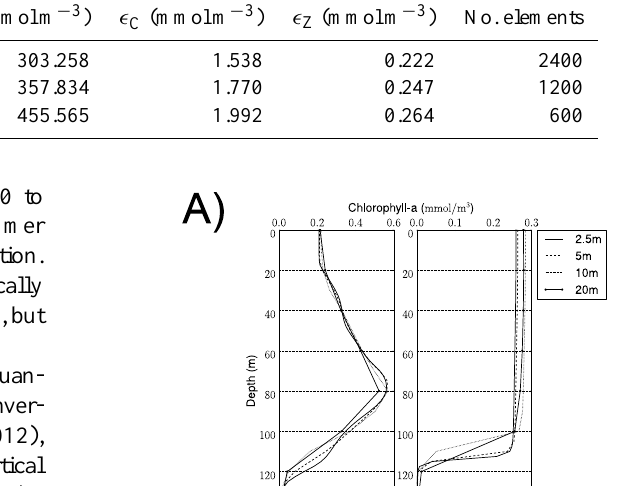
Table 4. The rms error, (cid:15) , of fixed-mesh simulations compared to the simulation with 2.5m vertical resolution at Station India. (cid:15) is shown for MLD, and the L2 norm of nutrient, primary productivity, chlorophyll and zooplankton. See Fig. 8 also. Res (m)